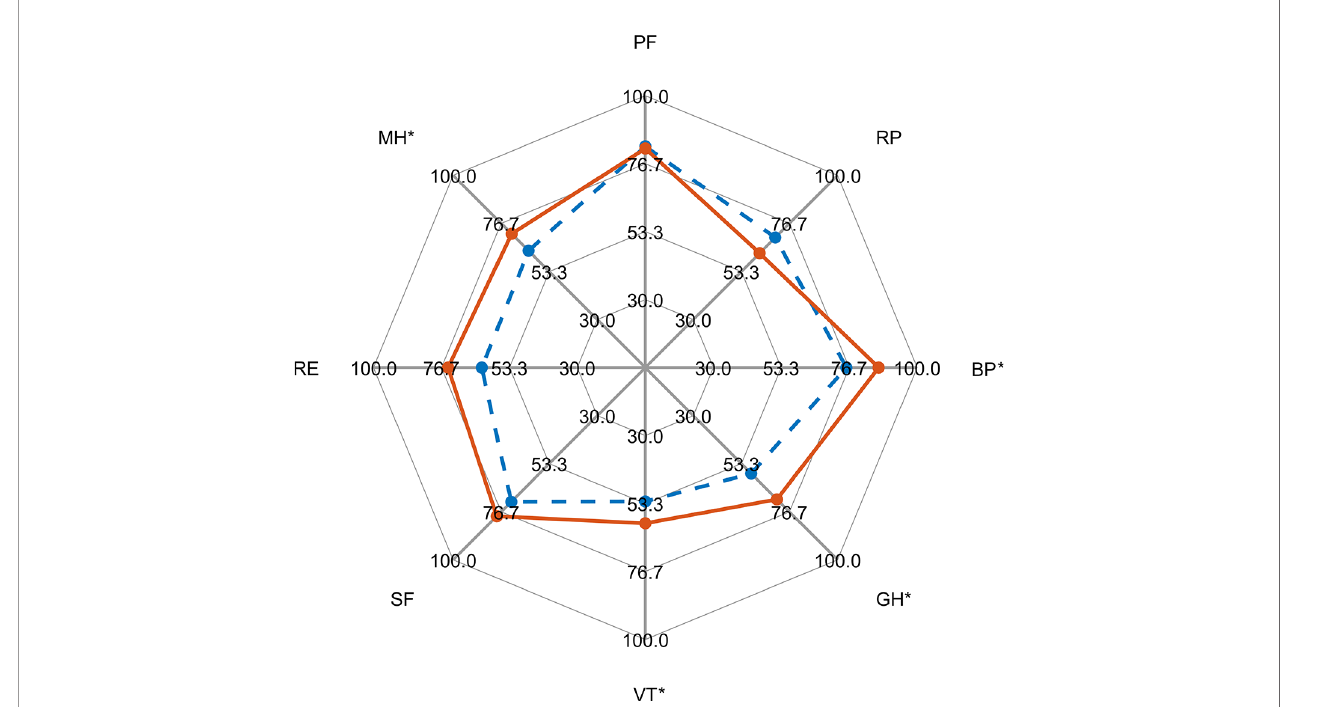
FIGURE 2 | Radar graph of SF-36 raw values before surgery (blue dashed line) and at follow-up (red solid line). Domains with a signi fi cant difference (paired t-test) are marked with an